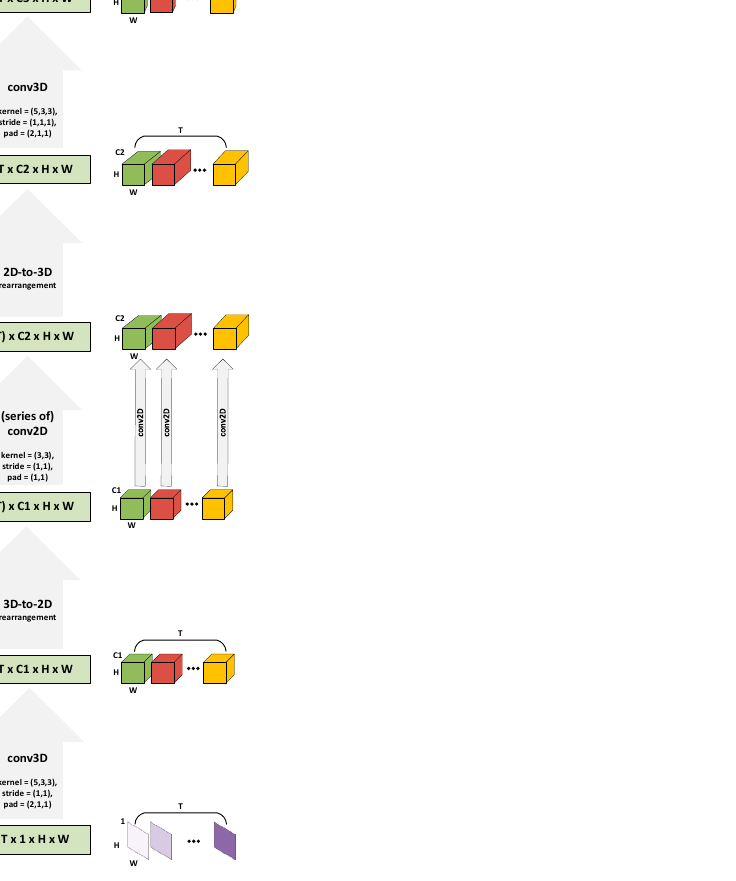
Figure 2. The ALSOS module. The flowchart of one input sequence is demonstrated from bottom to top while the procedure steps (gray arrows) as well as the size of the data volumes (green boxes) are represented on the left side, and the corresponding volumes are presented on the right side of the scheme. The H and W correspond to spatial sizes (height and width) while C1, C2, and C3 are the depth sizes (number of channels) of the volumes and the T is the length of the sequence (with the symbol (*) represents the scalar multiplication operation). Ultimately, the ALSOS module provides a sequence-to-sequence mapping utilizing both spatiotemporal and spatial